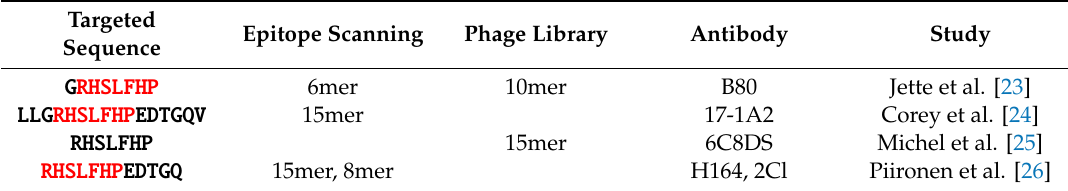
Table 1. Targeted epitope sequences of the human prostate specific antigen (hPSA) molecule, verified in previous studies.